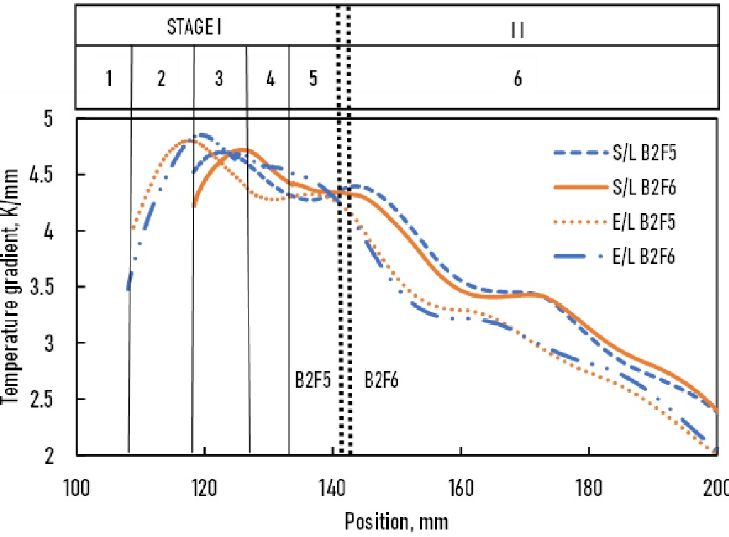
Figure 6. The temperature gradient vs. position of B2F5 and B2F6 samples.